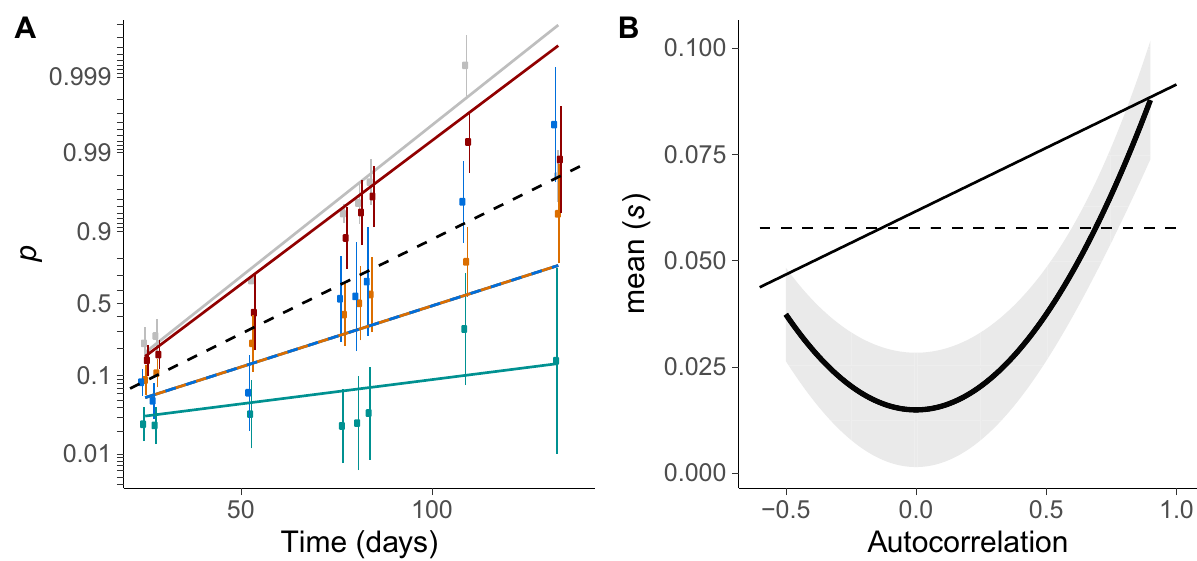
Fig 4. Influence of environmental autocorrelation on selection. (A) Frequency dynamics for treatments with different autocorrelations (-0.5 blue, 0 green, 0.5 orange, 0.9 red). Dots and error bars are the means and standard errors bootstrapped from the realized logit frequencies, and lines give the logistic state-space model predictions (Eqs (1) and (2)). Gray: constant environment with same mean salinity 2.4M. Dashed black line: prediction from the selection reaction norm built in constant environments (Eq (3)). (B) Influence of autocorrelation on mean selection. The black thick curve and ribbon show the mean selection coefficient s estimated by the logistic state-space regression, and its 95% confidence intervals computed with the delta method. Lines are the predictions from the univariate (dashed line, Eq (2)) and bivariate (solid line, Eq (5)) selection reaction norm.